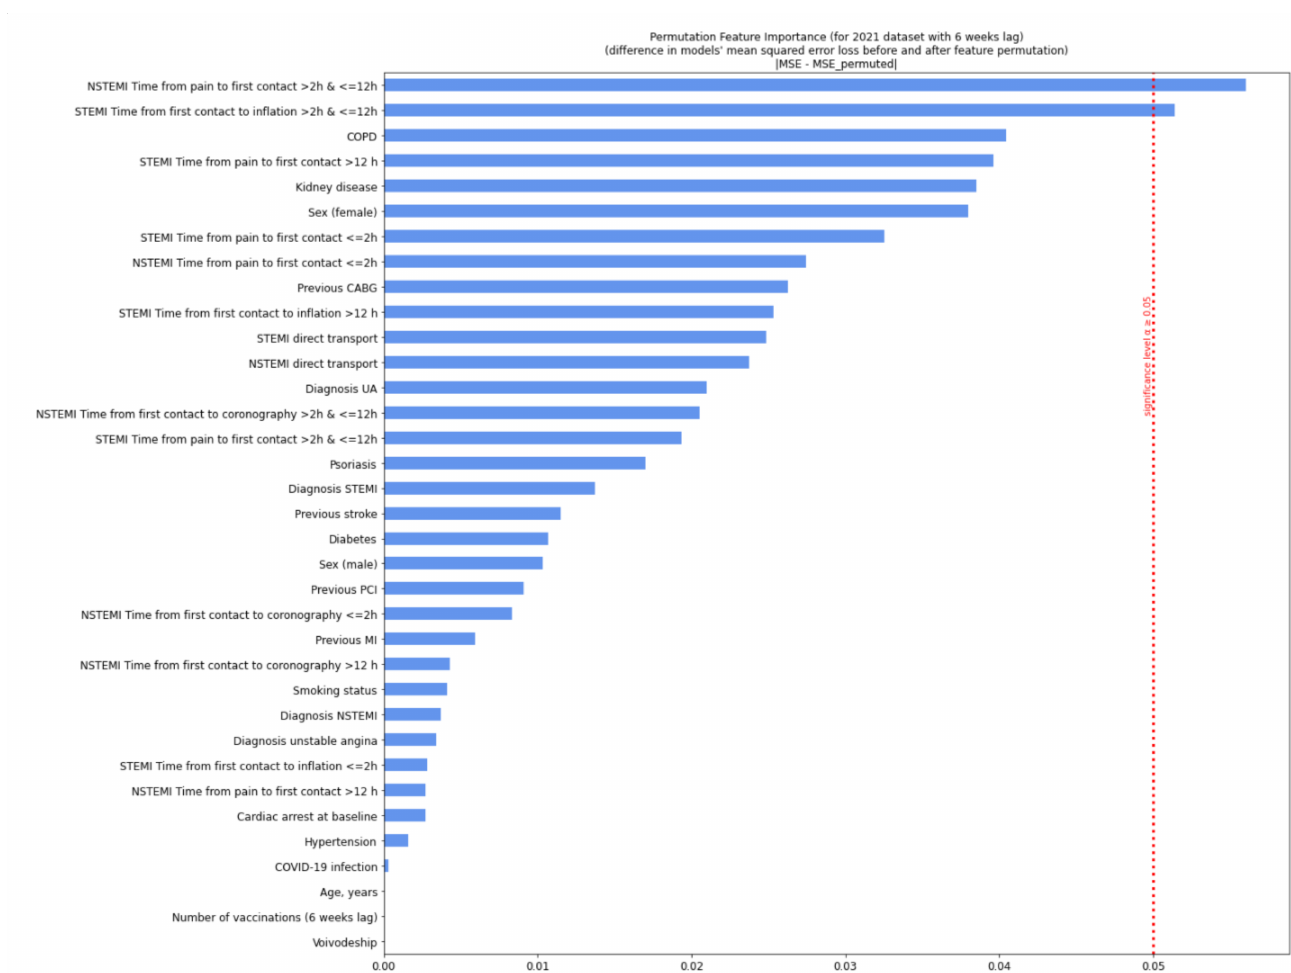
Figure 5. Permutation feature importance analysis for patients in 2021 with a six-week lag. Diagram shows a decrease in the model’s efficiency when values in single individual features are randomly shuffled column-wise and the rest of the features are left unchanged. We measured the neural network efficiency by calculating the mean squared error (MSE) between the target value (true number of deaths during the procedure) and the predicted value (model’s output). The calculation was conducted for each row from data separately and then averaged. In permutation feature importance, the difference between the MSE error from the neural network, the predicting value from the non-preprocessed dataset, and the MSE error from the neural network, the predicting value from the permuted dataset was measured and showed a decrease on the plot. Variables, when permuted, were affected most in the model’s efficiency decrease and exceeded the